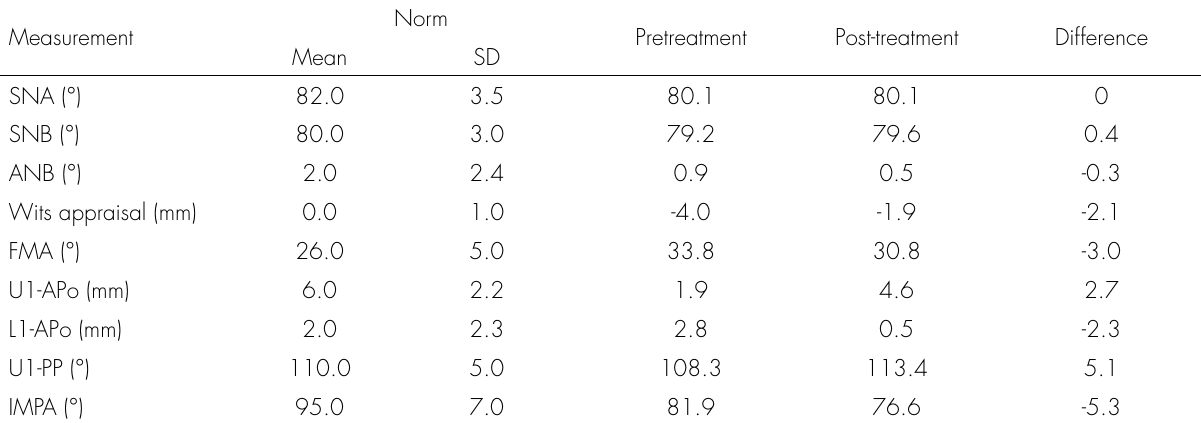
Table I. Cephalometric analysis.